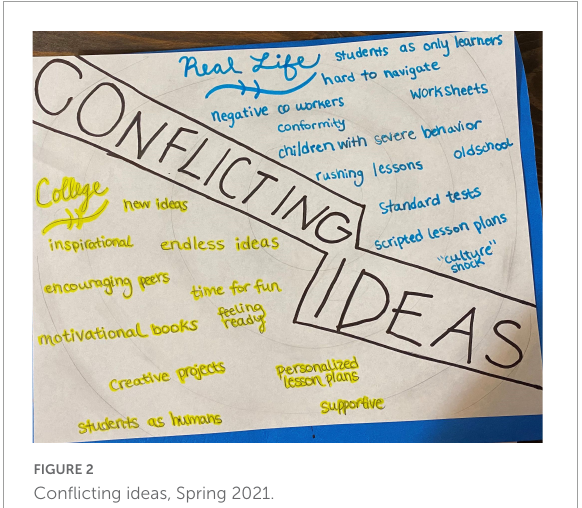
FIGURE2 Conflicting ideas, Spring